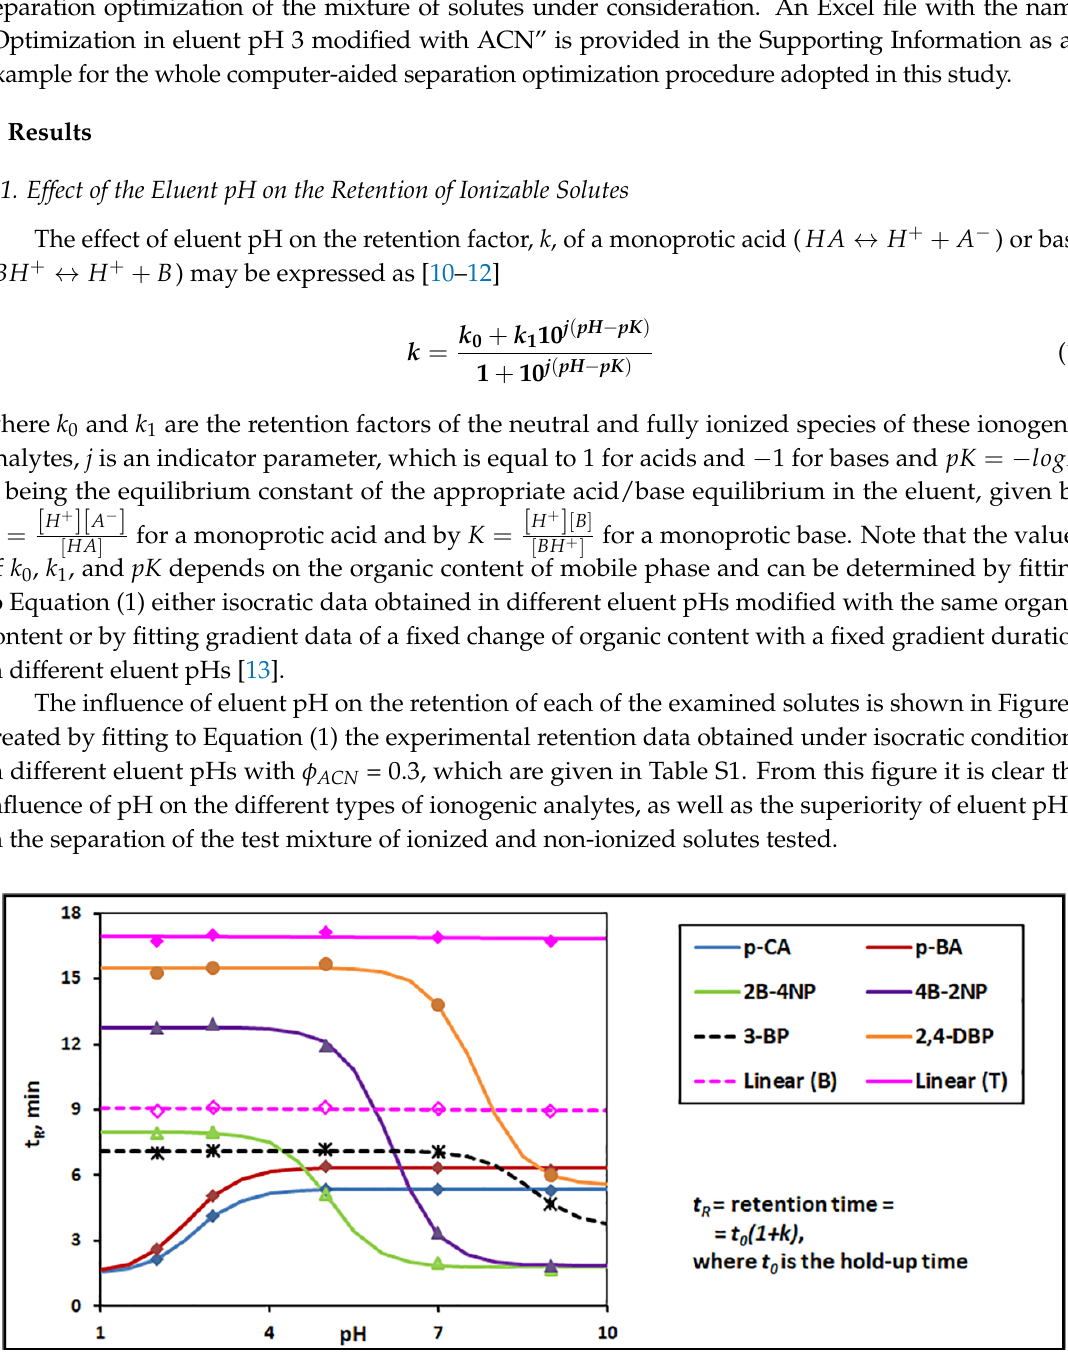
Figure 1. Variation of t R as a function of mobile phase pH for each of the examined solutes. Points are experimental data taken from Table S1 for isocratic runs performed in different eluent pHs with ϕ ACN = 0.3. Lines are obtained by fitting experimental data of ionized solutes to Equation (1).